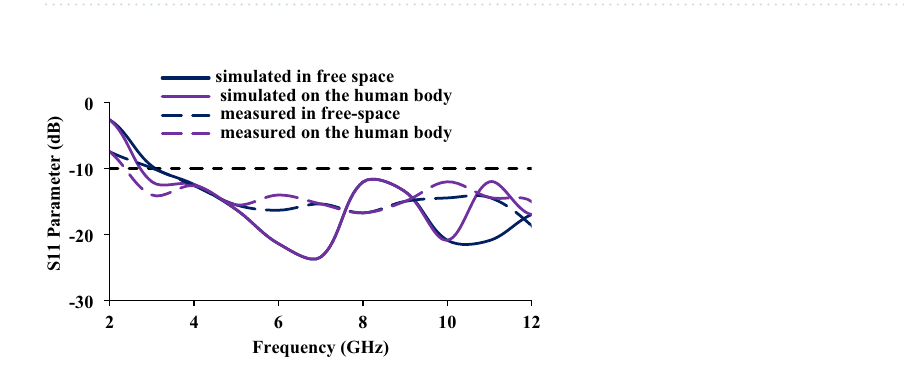
Figure 23. Imported human hand model and the proposed antenna.